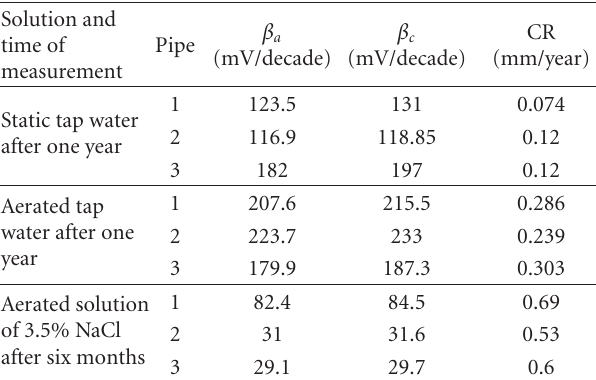
Table 5: Tafel slopes and corrosion